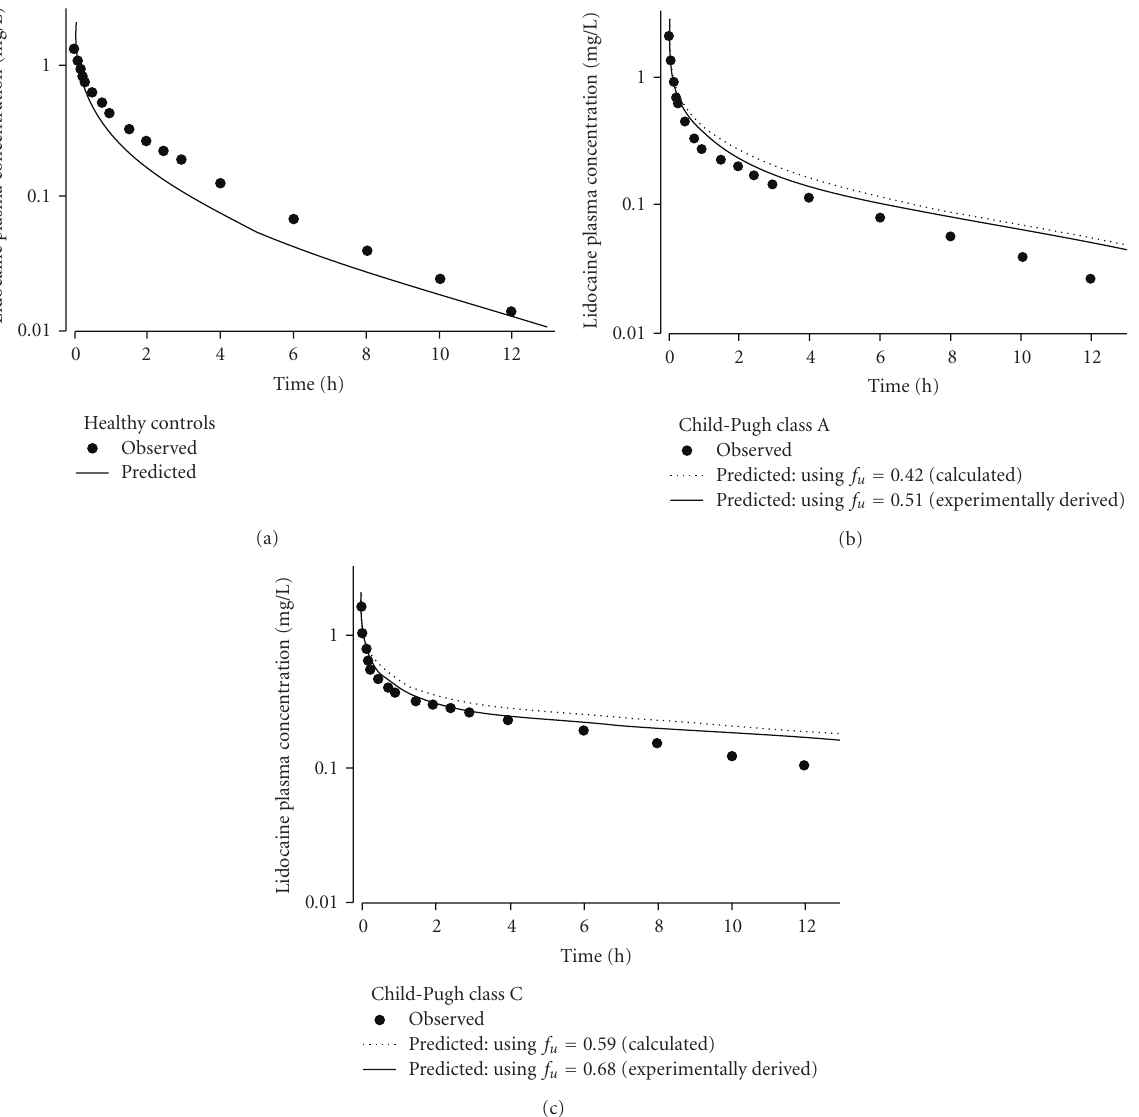
Figure 4: Comparison of lidocaine predicted and observed mean plasma concentration-time curves in healthy controls (a) and patients with Child-Pugh class A (b) and class C liver cirrhosis (c). Model simulation results adapted from Edginton and Willmann [34].